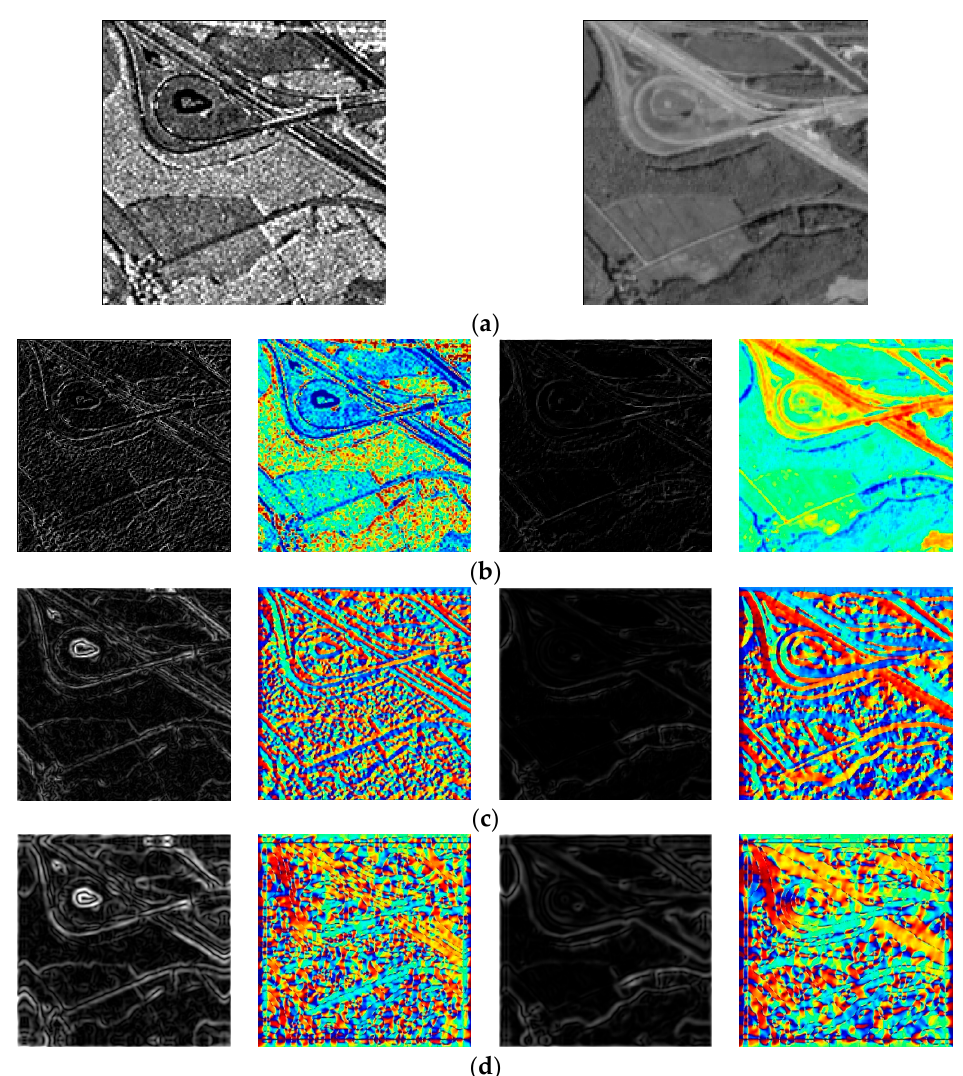
Figure 2. Comparison of gradient computation. ( a ) A pair of registered TerraSAR-X (X band, HH polarization) and Google earth (panchromatic band) images in the Netherlands. The size of each image is 330 × 330 pixels. Image spatial resolution is 1.85 (unit: meter). ( b ) The gradient magnitude and orientation of the SAR and optical images computed by the grayscale difference-based gradient operator [8]. ( c ) The magnitude and orientation of the SAR and optical images computed by the gradient operator in the SAR-SIFT [17] matching method. ( d ) The magnitude and orientation of the SAR and optical images computed by the proposed gradient operator. The orientation values shown in these figures are colored with a standard jet color map where blue and red are adopted to denote minimum and maximum values, respectively. Those values in between are interpolated through blue, green, yellow, and red.